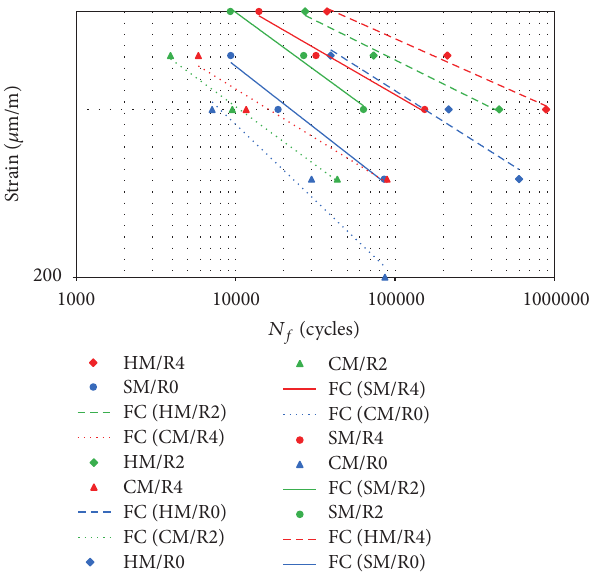
Figure 4: Fatigue life 𝑁 𝑓 versus initial strain: unaged mixes.